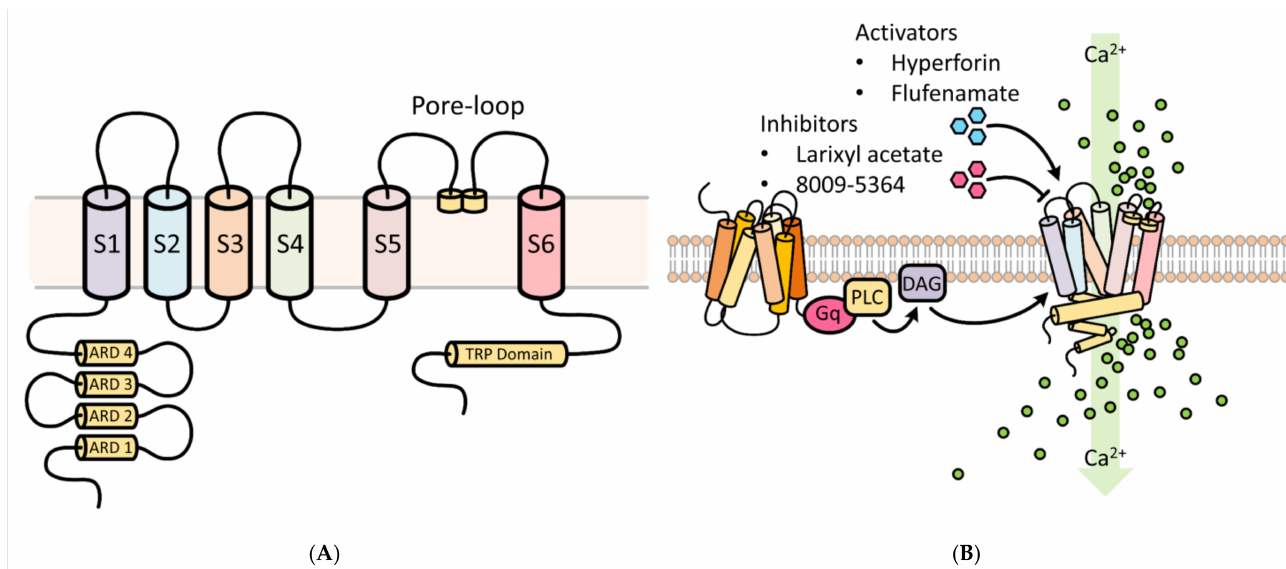
Figure 1. Functional aspects of transient receptor potential cation 6 (TRPC6) involved in Ca 2+ cellular influx. ( A ) Structural features of the TRPC6 channel. TRPC6 possesses 6 membrane-spanning domains and 3 conserved domains, namely, a pore-loop motif, four NH2 terminal ankyrin repeat domains (ARD), and a COOH-terminal TRP box motif. The ARD domains participate in channel heterodimerization and trafficking, whereas the TRP domain regulates binding with the cytoskeleton and translocation to the cell surface. The pore-loop region (between the S5 and S6) is associated with an extracellular selectivity filter and an intracellular gate and allows for the passage of cations. ARD: ankyrin repeat domain; S1–S6 are the first to sixth transmembrane domains; TRP, transient receptor potential. ( B ) Regulators of TRPC6 channel activity. Receptor tyrosine kinases (RTKs) or G protein-coupled receptors (shown) increase TRPC6 activity by stimulating phospholipase C (PLC) to generate diacylglycerol (DAG). Several key experimental activators and inhibitors of TRPC6 are described in Section